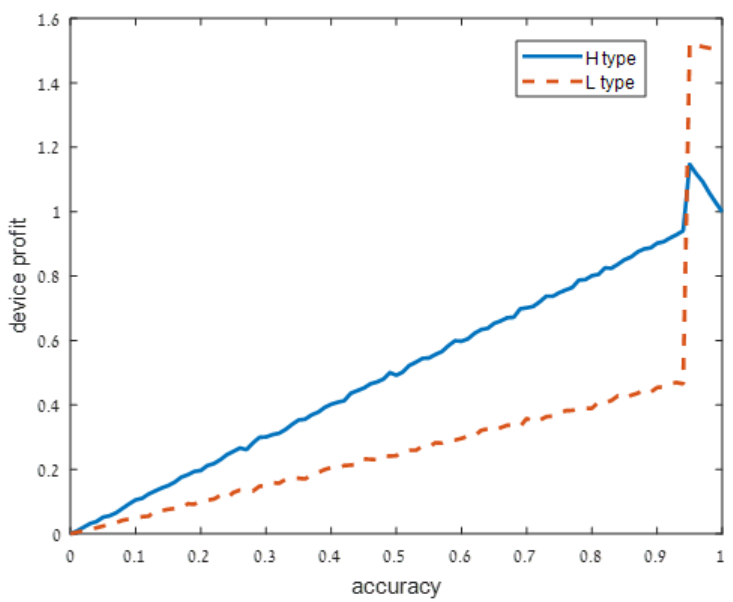
Figure 1. Extremely noisy signal: (cid:101) =